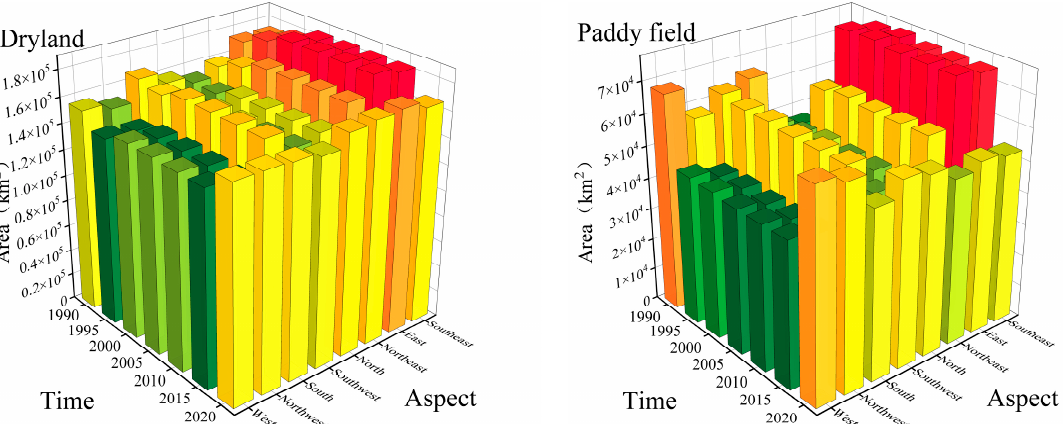
Figure 4. Change in the slope aspects of paddy field and dryland. (For detailed data, refer to Table S4 in the Supplementary Materials).